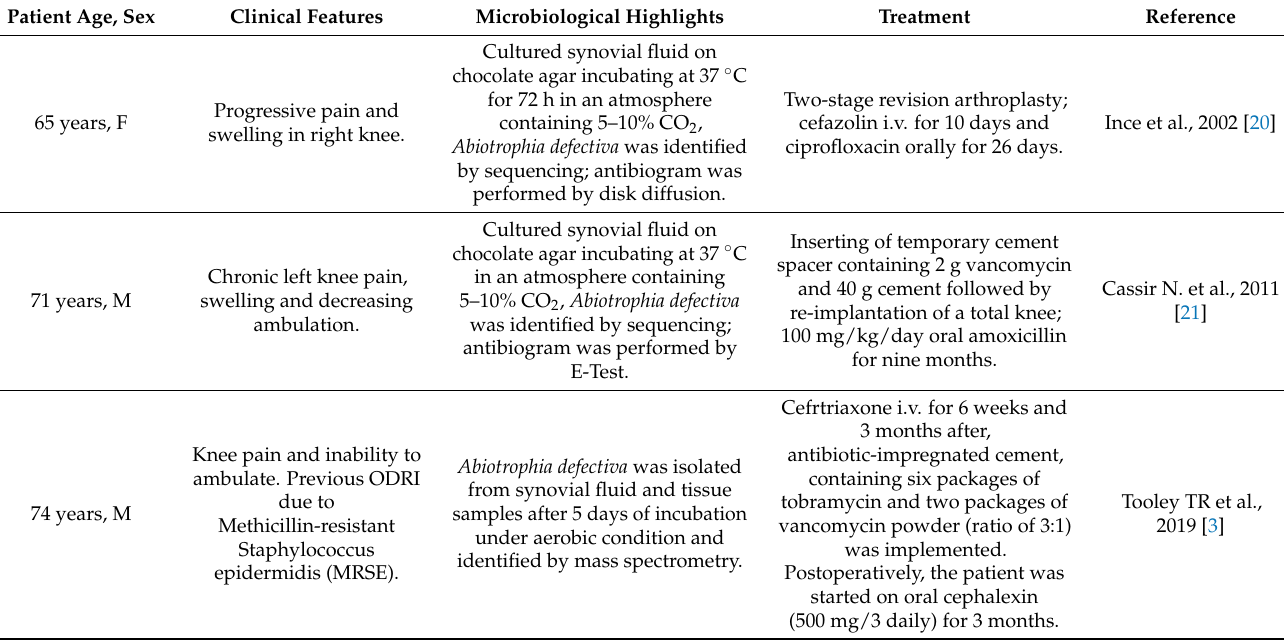
Table 2. Literature review on Abiotrophia defectiva and Finegoldia magna in the orthopedic